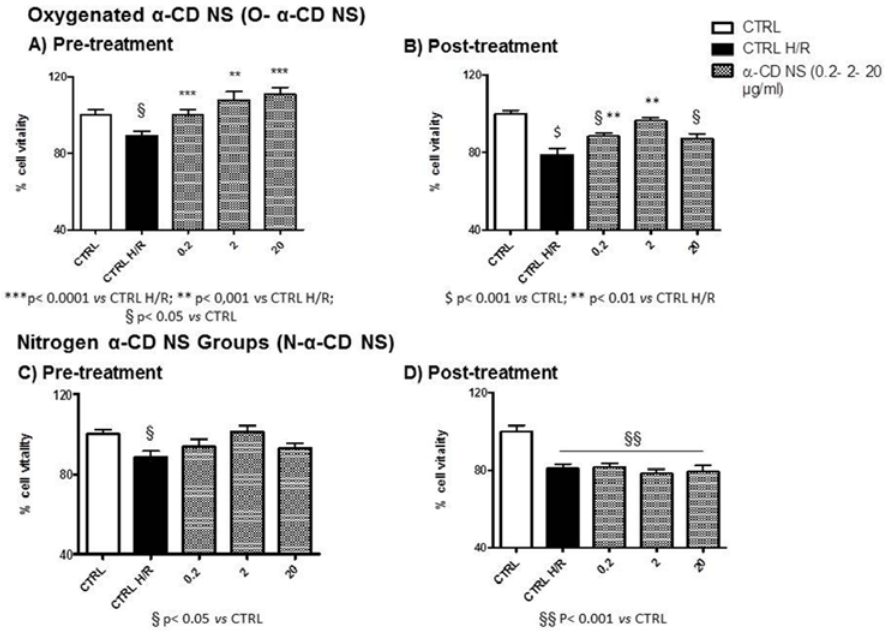
Figure 7. Cell vitality of α-CD POLY treated H9c2 cells and H/R conditions. ( A ) Pre-treatment with O-α-CD POLY (0.2, 2, and 20 µg/mL); ( B ) Post-treatment with O-α-CD POLY (0.2, 2, and 20 µg/mL); ( C ) Pre-treatment with N-α-CD POLY (0.2, 2, and 20 µg/mL); ( D ) Post-treatment with O-α-CD POLY (0.2, 2, and 20 µg/mL) compared to the untreated control group (CTRL) and the hypoxia– reoxygenation group (CTRL H/R). Data were normalized to mean value in control conditions and expressed as a percentage.